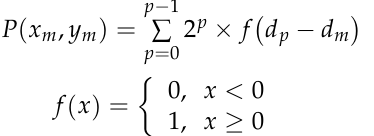
Figure 4. Circular LBP examples. ( a ) r = 1, n = 8 ( b ) r = 2, n = 16 ( c ) r = 2, n = 8.